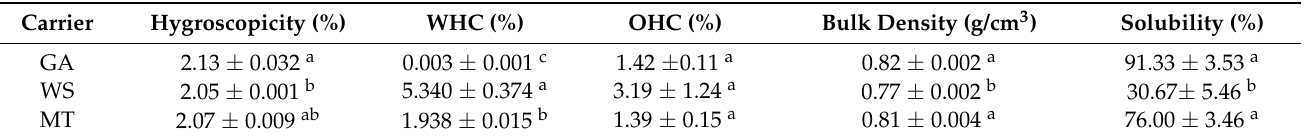
Table 2. Techno-functional properties of passion fruit peel freeze-dried powders obtained with MT, WS, and GA as